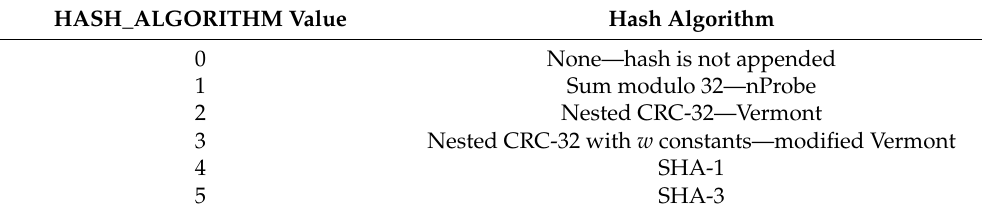
Table 3. Values of HASH_ALGORITHM parameter for netprobe_hash_top module configuration.